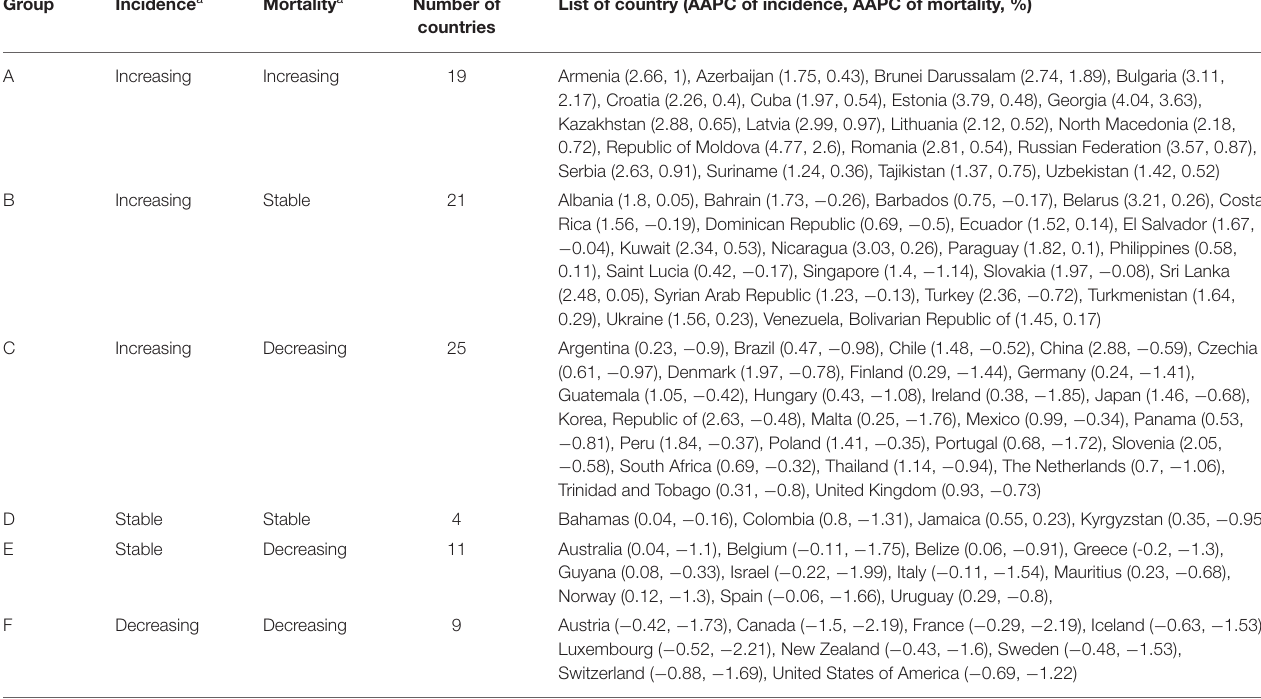
TABLE 2 | Patterns of trends in incidence and mortality for prostate cancer from 2000 to 2019 among 89 countries. Group Incidence a Mortality a Number of List of country (AAPC of incidence, AAPC of mortality, countries